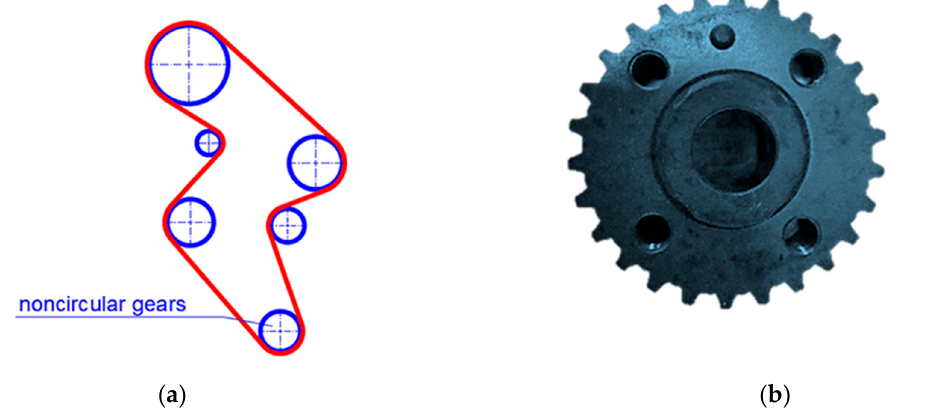
Figure 1. The scheme of a modern internal combustion engine timing system ( a ) with a non-circular wheel ( b ).